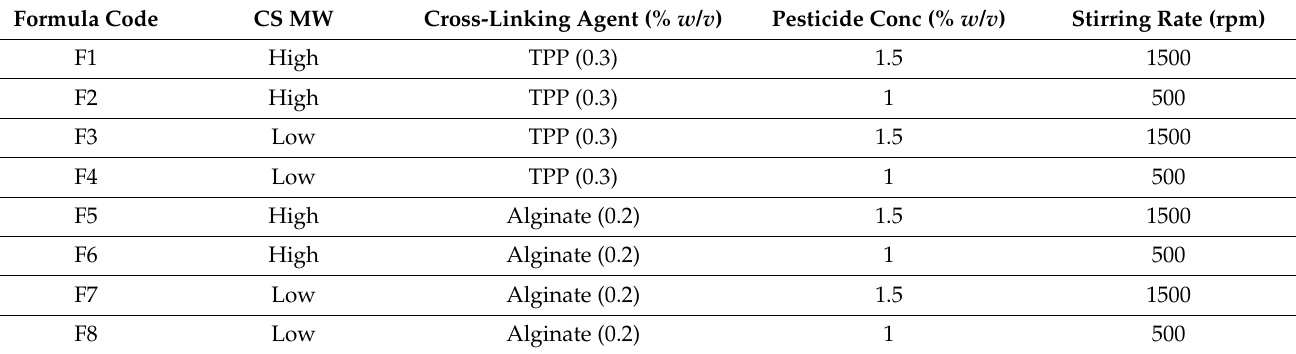
Table 2. Compositions of lambda-cyhalothrin